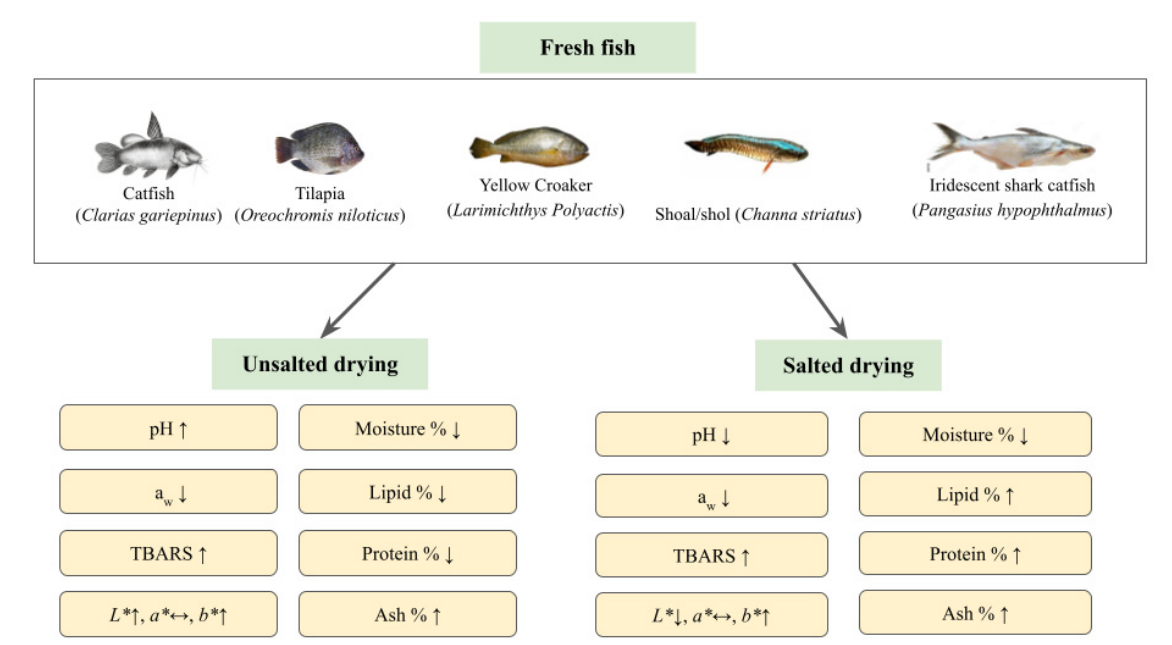
Figure 4. The changes of physicochemical and biochemical properties of various dried fish.